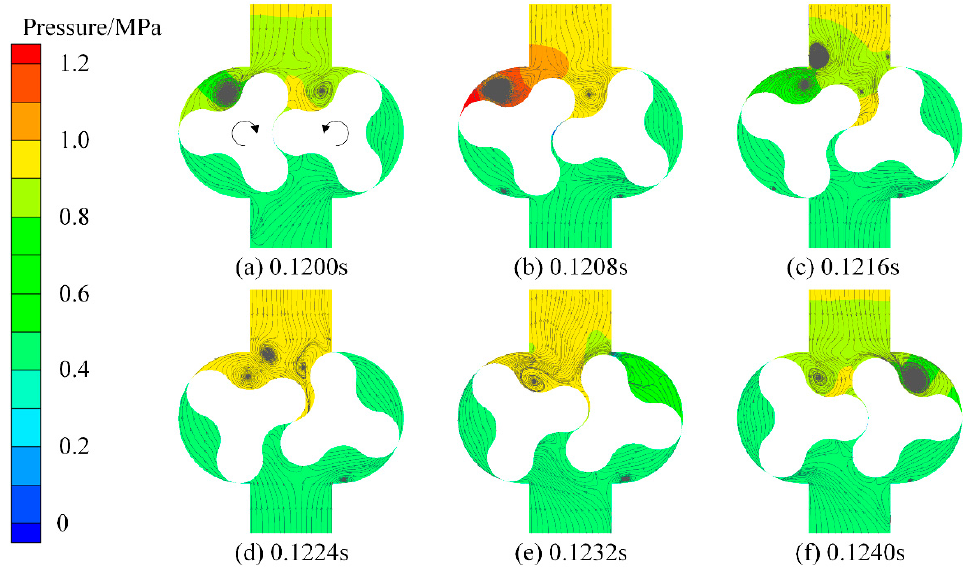
Figure 10. Pressure streamline contours of the Roots pump when the inlet CO 2 volume fraction is 0.99. Flow time: ( a ) 0.1200s; ( b ) 0.1208s; ( c ) 0.1216s; ( d ) 0.1224s; ( e ) 0.1232s; ( f ) 0.1240s.